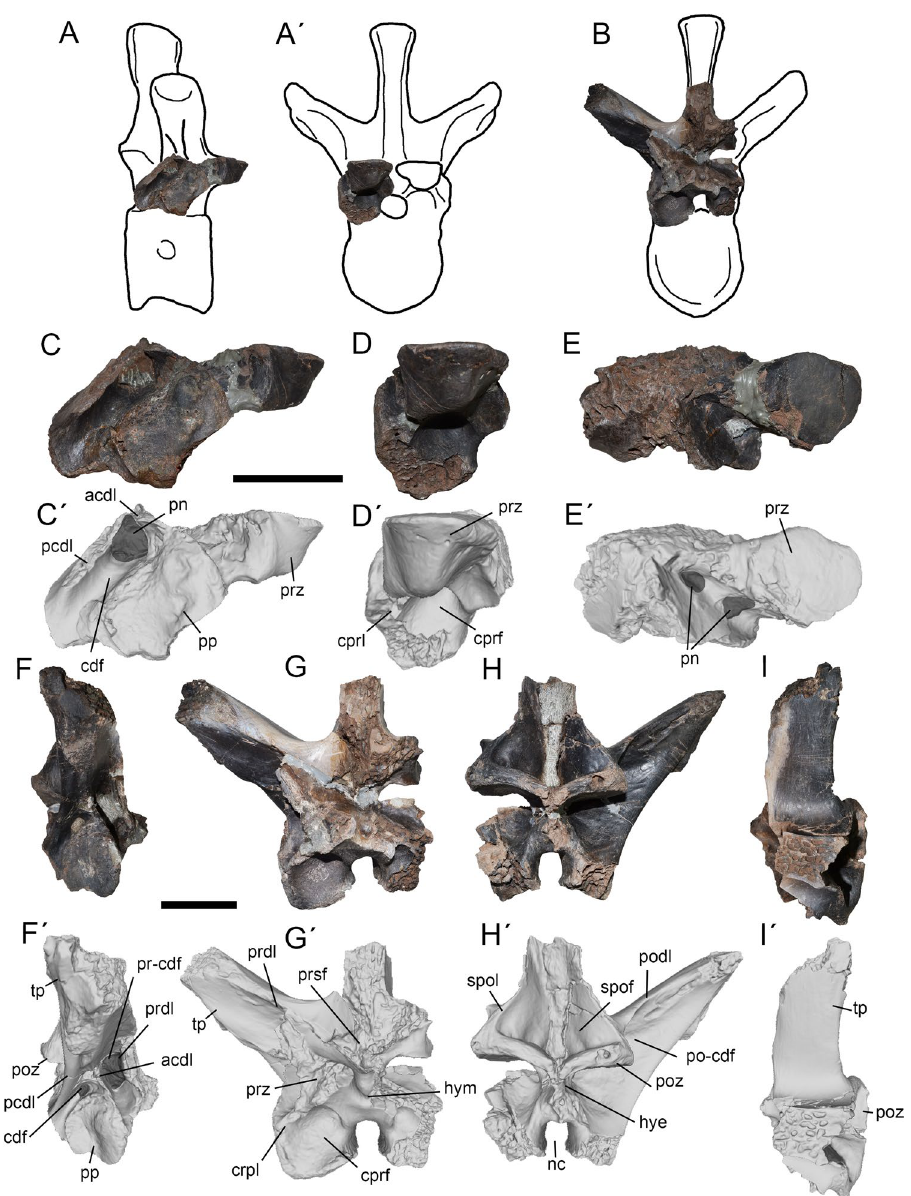
Figure 5. Fifth and sixth dorsals of Maip . Fifth dorsal, interpretative drawing showing the preserved parts ( A , A´ ), lateral ( C , C´ ), anterior ( D , D´ ) and dorsal ( E , E´ ) views. Sixth dorsal, interpretative drawing showing the preserved parts ( B ), lateral ( F , F´ ), anterior ( G , G´ ), posterior ( H , H´ ) and dorsal ( I , I´ ) views. Scale bar: 5 cm. Abbreviations: acdl; anterior centrodiapophyseal lamina; cdf; centrodiapophyseal fossa; cprf; centroprezygapophyseal fossa; cprl; centroprezygapophyseal lamina; hye, hyposphene; hym, hypantrum; nc, neural canal; pcdl; posterior centrodiapophyseal lamina; pn, pneumatopore; podl; postzygapophyseal lamina; poz, postzygapophyses; po-cdf; postzygapophyseal-centrodiapophyseal fossa; prdl; prezygodiapophyseal lamina; prsf; prespinal fossa; pp, parapophyses; prz, prezygapophyses; spof; spinopostzygapophyseal fossa; spol; spinopostzygapophyseal lamina; tp, transverse